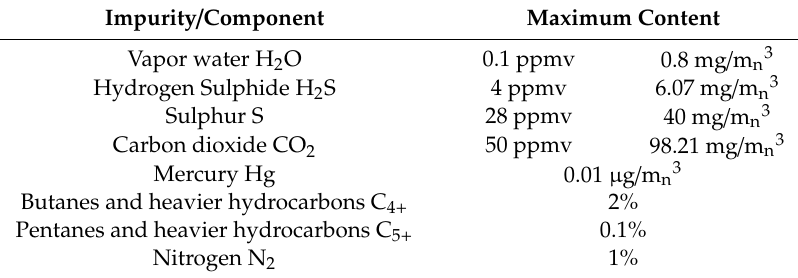
Table 3. Maximum impurities limits for liquefied natural gas